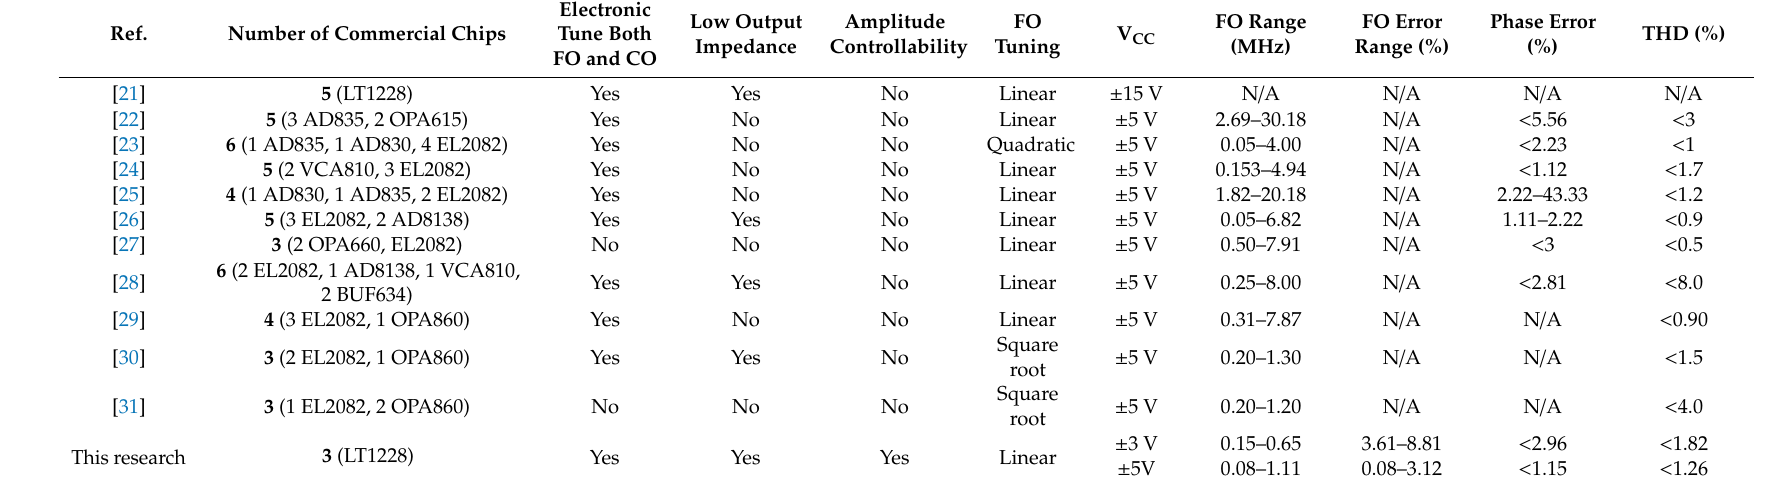
Table 1. Comparison of relevant voltage or current controlled quadrature oscillators using commercially available ICs.